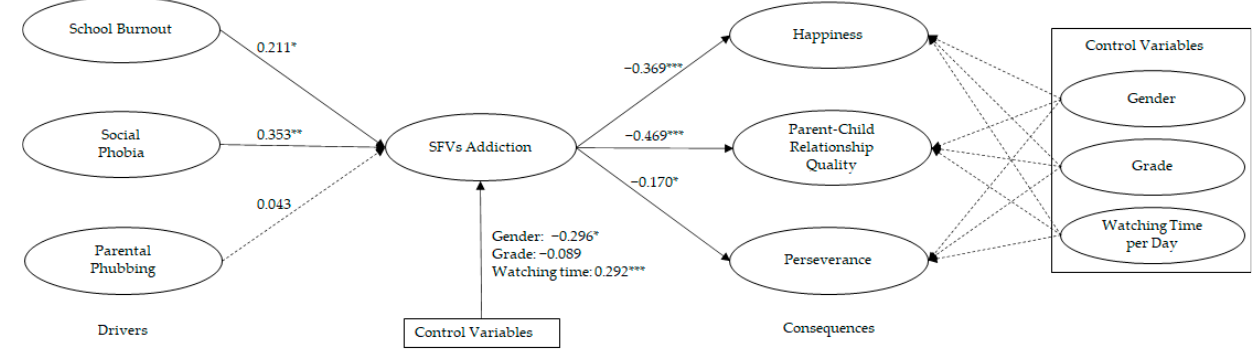
Figure 2. Model test results. Note: * p < 0.05; ** p < 0.01; *** p < 0.001. Table 6. Mediation test.